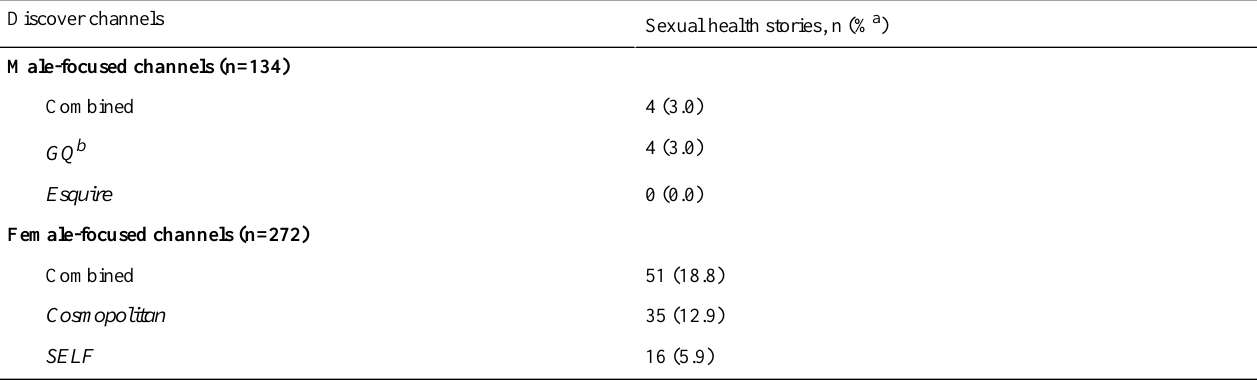
Table 3. Number and percentages of sexual health stories from male- and female-focused Discover channels.